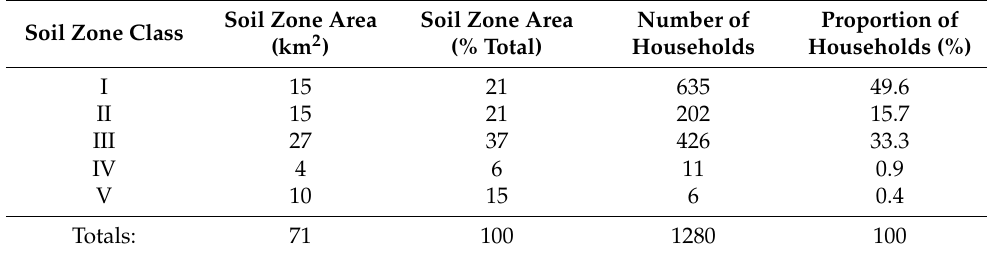
Table 3. Soil zones and total residential